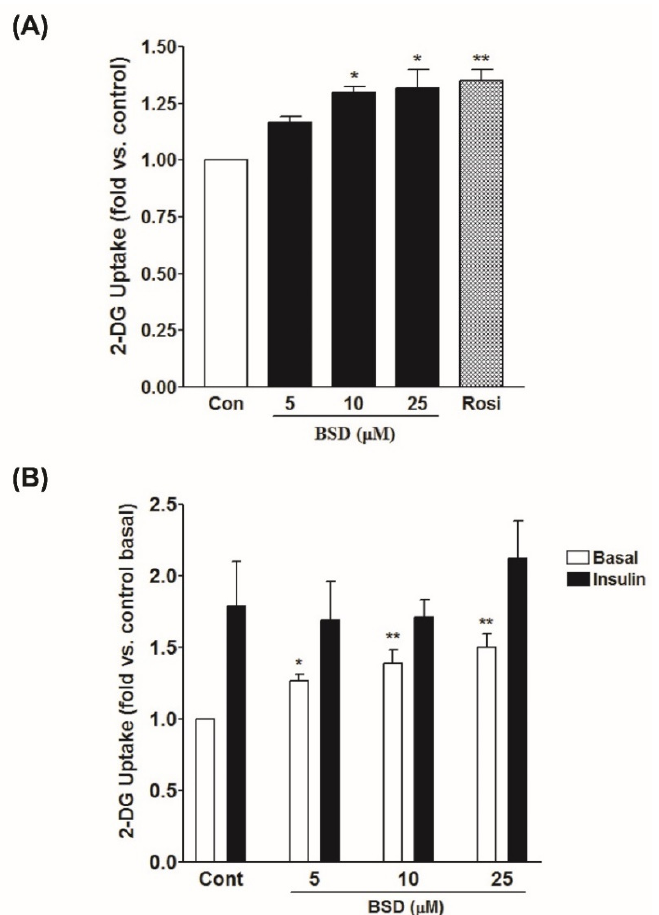
Figure 4. Effect of BSD on 2-deoxyglucose uptake in L6-GLUT4 myc myotubes. Cells were incubated for 16h with increasing concentrations of BSD( A ). After incubation, cells were left untreated (white bars) or stimulated with 100 nM insulin for 20 min (black bars) after 3h serum starvation ( B ). Glucose uptake was measured as described in the Materials and Methods section. Results are expressed as fold stimulation over control. Results shown are mean ± SE of three independent experiments. * p < 0.05, ** p < 0.01 relative to respective control condition.